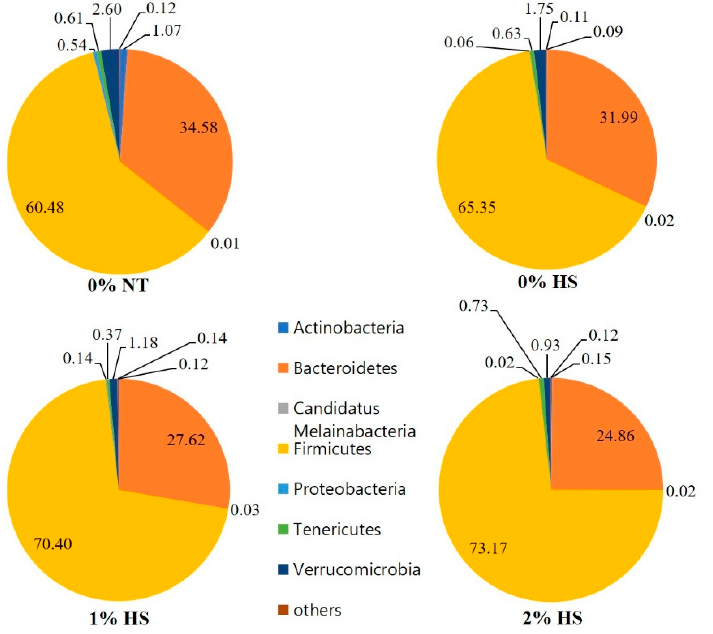
Figure 5. Effects of dietary steam-exploded pine particles supplementation to the chickens kept at either thermoneutral or heat stress on the composition of cecum microflora at Phylum level. The treatments were control diet containing 0% steam-exploded pine particles (SPP) at thermoneutral temperature (0% NT), control diet with acute heat stress (0% HS), 1% SPP-supplemented diet at acute heat stress (1% HS), and 2% SPP-supplemented diet at acute heat stress (2% HS). The thermoneutral birds were maintained at 21.0 °C while the temperature of the heat-stressed room was raised to 31 °C within the first three hours and then maintained for another three hours that makes the total HS period of six hours.